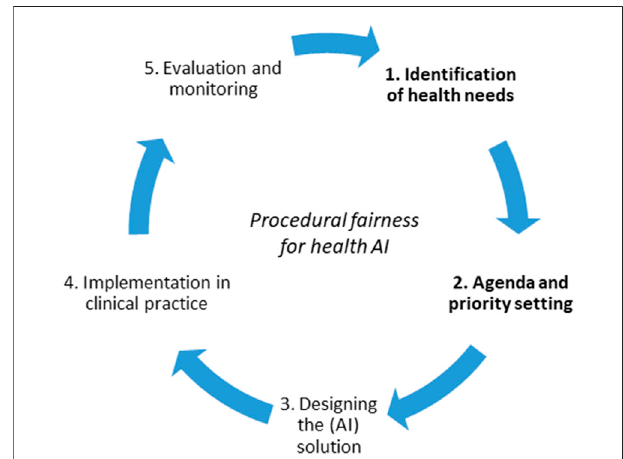
FIGURE 1 | Procedural fairness for priority-setting in health AI, with special attention for steps 1 and 2. Adapted from the Policy Cycle (Howlett & Giest,